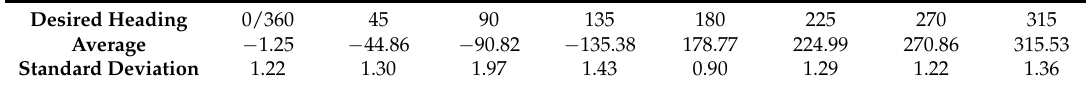
Table 4. Heading measurement Table 3. Step measurements in different thresholds.